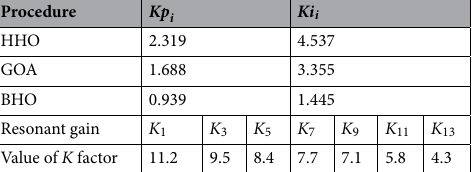
Table 3. Optimized PI controller gains of PI-MR and resonant gain